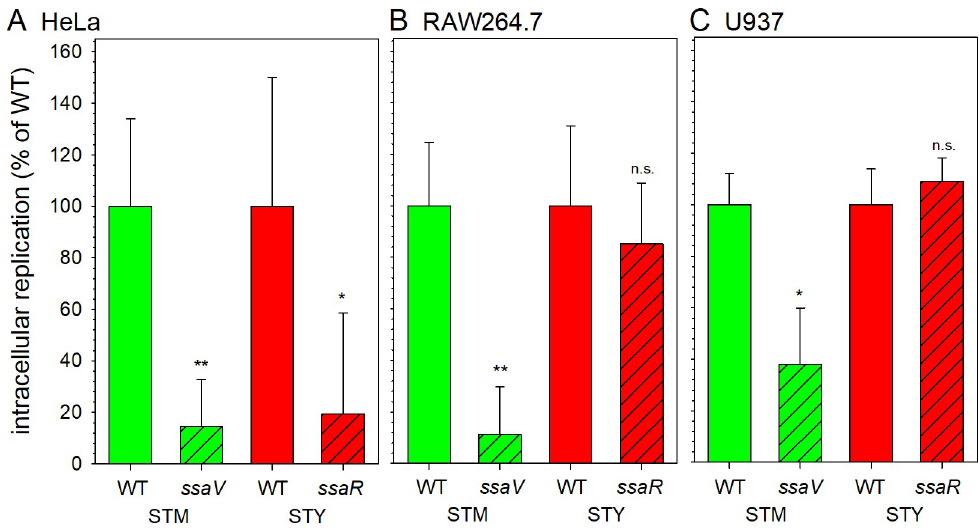
Fig 7. SPI2-T3SS-deficient STY are reduced in intracellular replication in HeLa cells. Hosts cells were infected with WT (open bars) or SPI2-T3SS-deficient (hatched bars, ssaV and ssaR encode subunits of the SPI2-T3SS) strains of STM (green) or STY (red) at MOI 1. Intracellular replication was determined by gentamicin protection assays comparing intracellular CFU recovered 1 h p.i. and 24 h p.i. A) Intracellular replication in HeLa cells. STM was cultured overnight, diluted 1:31 in fresh LB broth, subcultured 2.5 h, and used for infection. STY was incubated in 3 ml LB broth for 8 h, reinoculated 1:100 in 10 ml fresh LB broth and grown for 16 h under microaerophilic conditions before used as inoculum in infection B, C) Bacterial strains were grown overnight in LB and aliquots were used to infect macrophages. B) Intracellular replication of STM and STY in RAW264.7 macrophages. C) Intracellular replication of STM and STY in U937 cells. Assays were performed in three biological replicates and intracellular proliferation is expressed as percentage of WT. Student´s t -test was used for statistical analysis and significance is indicated as follows: n.s., not significant; � , P < 0.05; �� , P <